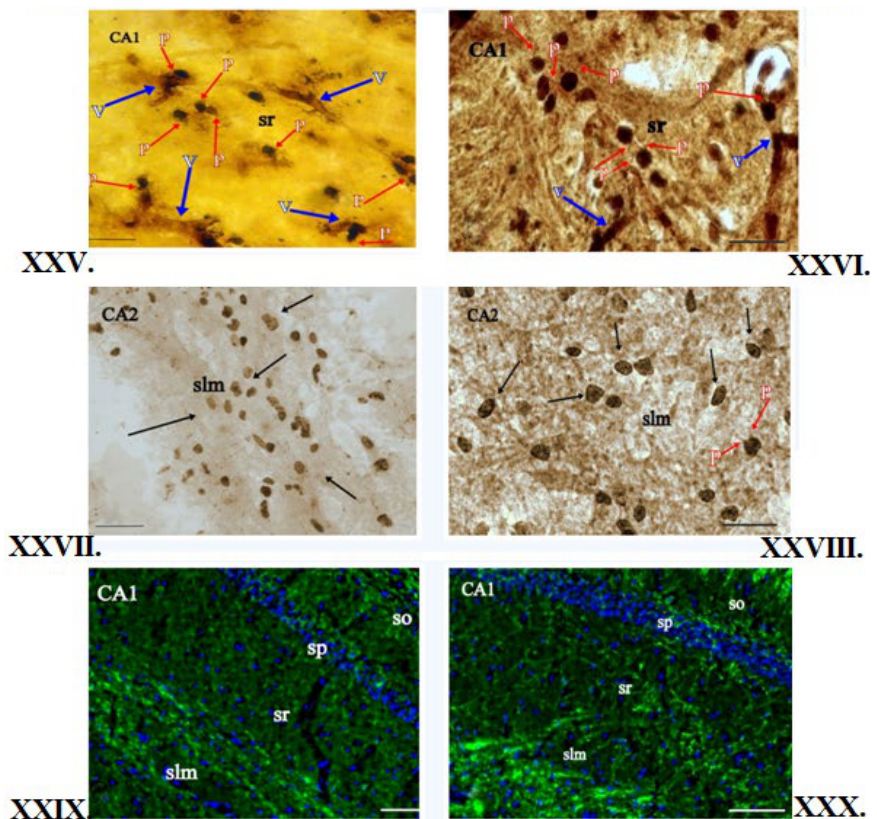
Figure 4. OLGs of the red kangaroo Hip. ( XXI , XXII )—Nissl staining (scale bar 10 µm, OLGs— ↓ ); ( XXIII , XXIV )—Klüver–Barrera staining (scale bar 10 µm); ( XXV , XXVI )—Glial tissue impregnation with silver salts (scale bar 20 µm;); ( XXVII , XXVIII )—Histochemical method for the detection of iron in OLGs (scale bar 20 µm); ( XXIX , XXX )—Immunofluorescence staining for MBP (scale bar 50 µm). Blue nuclei stained with DAPI; Notations: —male; —female; ↓ —processes of OLGs; N—neuron; ♂ ♀ v—blood vessels; p —processes of OLGs; SO—stratum oriens, SP—stratum pyramidale, SR—stra- tum radiatum, SLM—stratum lacunosum-moleculare; the description is in the text.